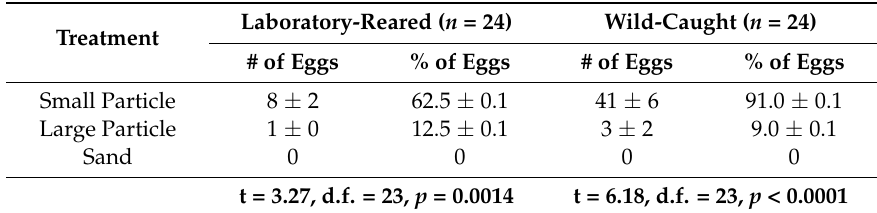
Figure 1. Percent of CRB laying no eggs (neither), laying all their eggs in either mulch substrate (small or large), within both mulch substrates at once (both), or in sand. n = 24 wild-caught; n = 24 lab-reared. Table 1. Mean ( ± SE) number of eggs laid and mean ( ± SE) percent of total eggs laid by CRB. Comparison of the numbers of eggs was conducted using a Wilcoxon non-parametric test.